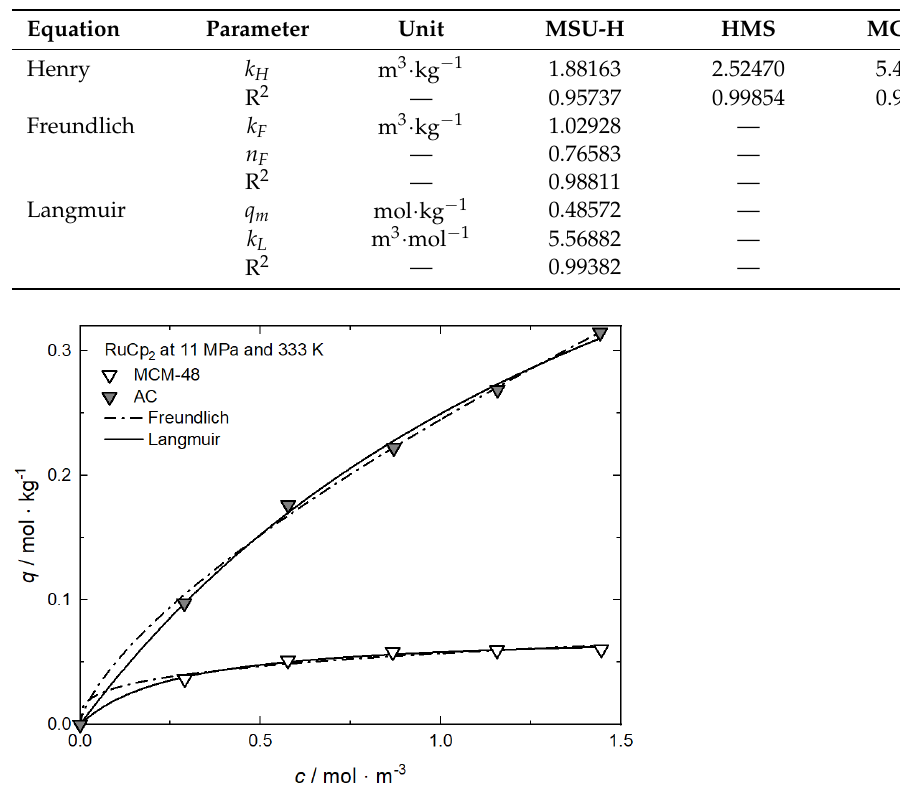
Figure A13. Uptake of RuCp 2 at 11 MPa and 333 K on different substrates; experimental data taken from [64].